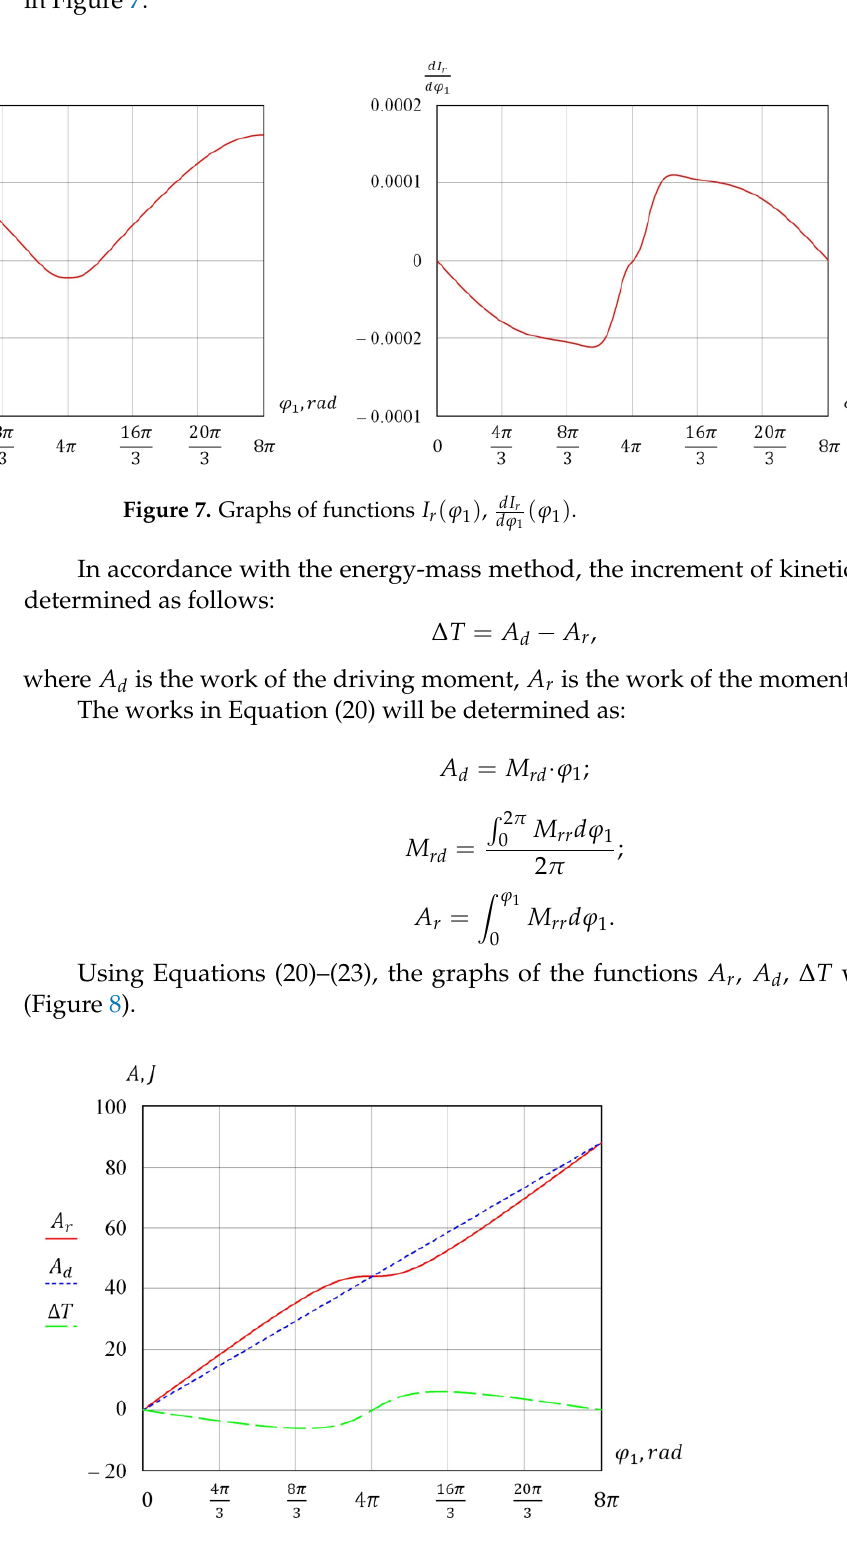
Figure 8. Graphs of functions 𝐴 (cid:3045) (𝜑 (cid:2869) ) , 𝐴 (cid:3031) (𝜑 (cid:2869) ) , ∆𝑇(𝜑 (cid:2869) ) . The angular velocity of the reduction link will be determined as [42]: